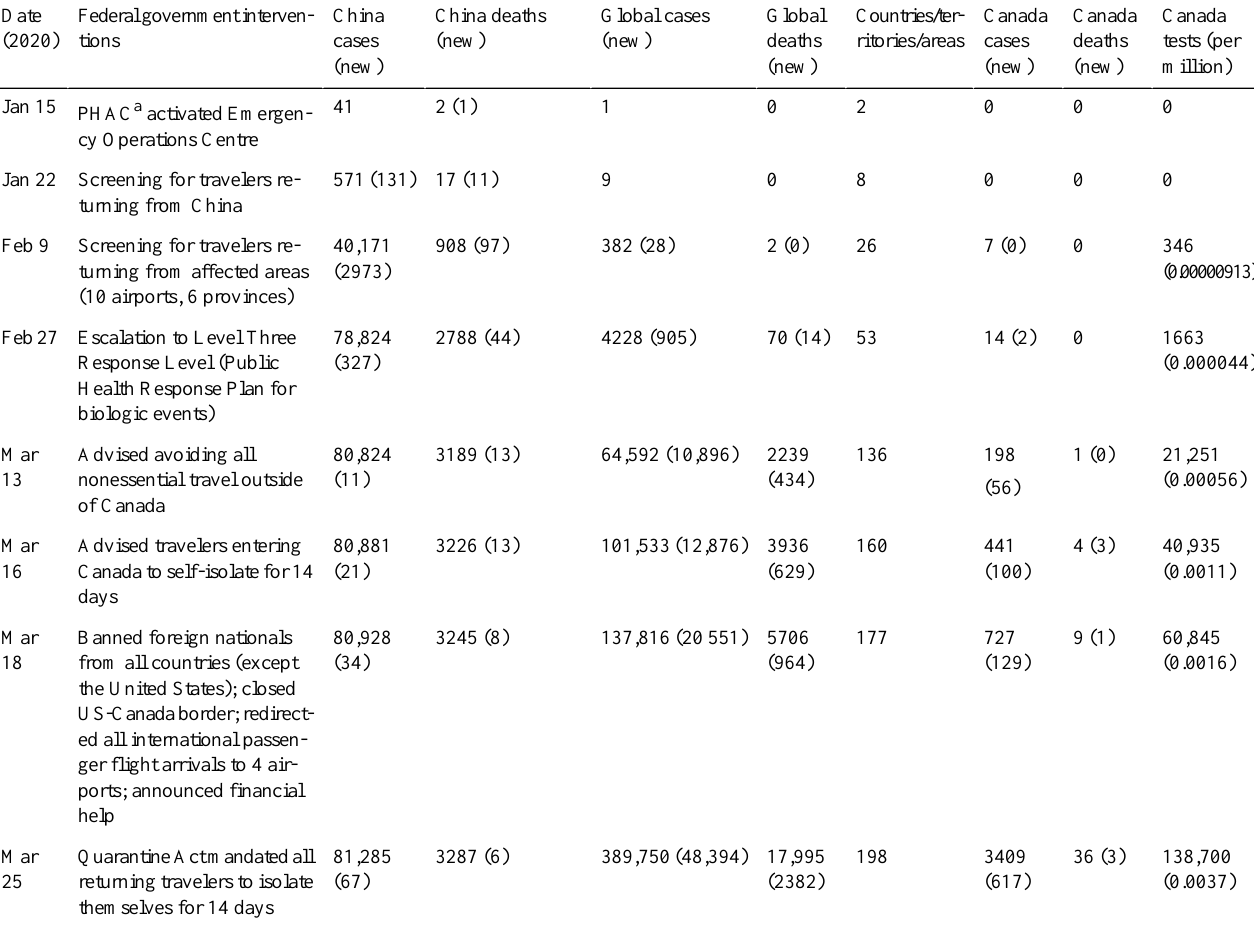
Table 1. Early response to the COVID-19 pandemic by the federal government of Canada.